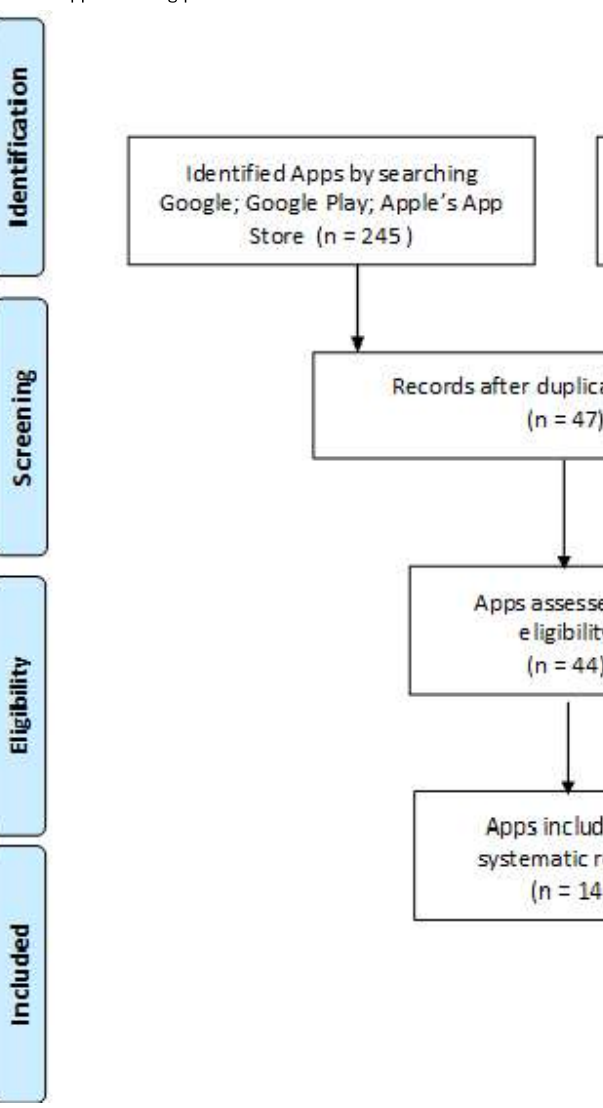
Figure 1. App screening